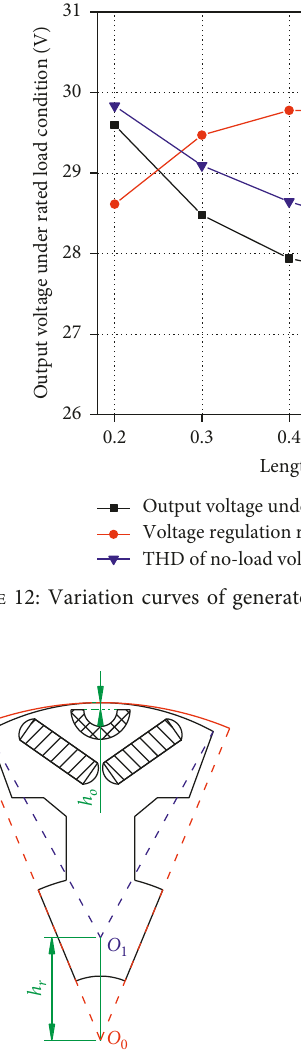
Figure 13: Schematic diagram of the nonuniform air